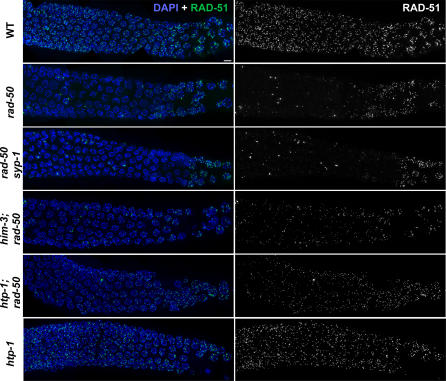
RAD-50 Dependence for RAD-51 Loading Is Partially Abrogated in him-3 and htp-1 MutantsImages show portions of germ lines extending from mid pachytene (left) through late pachytene/early diplotene (right) from hermaphrodites of the indicated genotypes that were exposed to 1 krad γ-irradiation 1 h prior to fixation. Both the rad-50 single mutant and the rad-50 syp-1 double mutant germ lines exhibit a “dark” region in which most nuclei lack RAD-51 foci, reflecting engagement of the RAD-50-dependent mode of RAD-51 loading that operates from meiotic prophase onset until the mid-pachytene to late pachytene transition. In the rad-50 syp-1 double mutant, the transition to nuclei with abundant IR-induced RAD-51 foci is observed at a more proximal position than in the rad-50 single mutant, at the very end of the pachytene stage, following exit from the persistent clustered chromosome configuration that is characteristic of mutants lacking SC central region components. In the him-3; rad-50 and htp-1; rad-50 double mutant germ lines shown, IR-induced RAD-51 foci are detected in nuclei throughout the mid-pachytene region, indicating that the requirement for RAD-50 is partially alleviated; however these IR-induced foci are less intense than those seen in the comparable regions of either the wild-type or htp-1 single mutant control germ lines. Scale bar = 5 μm.